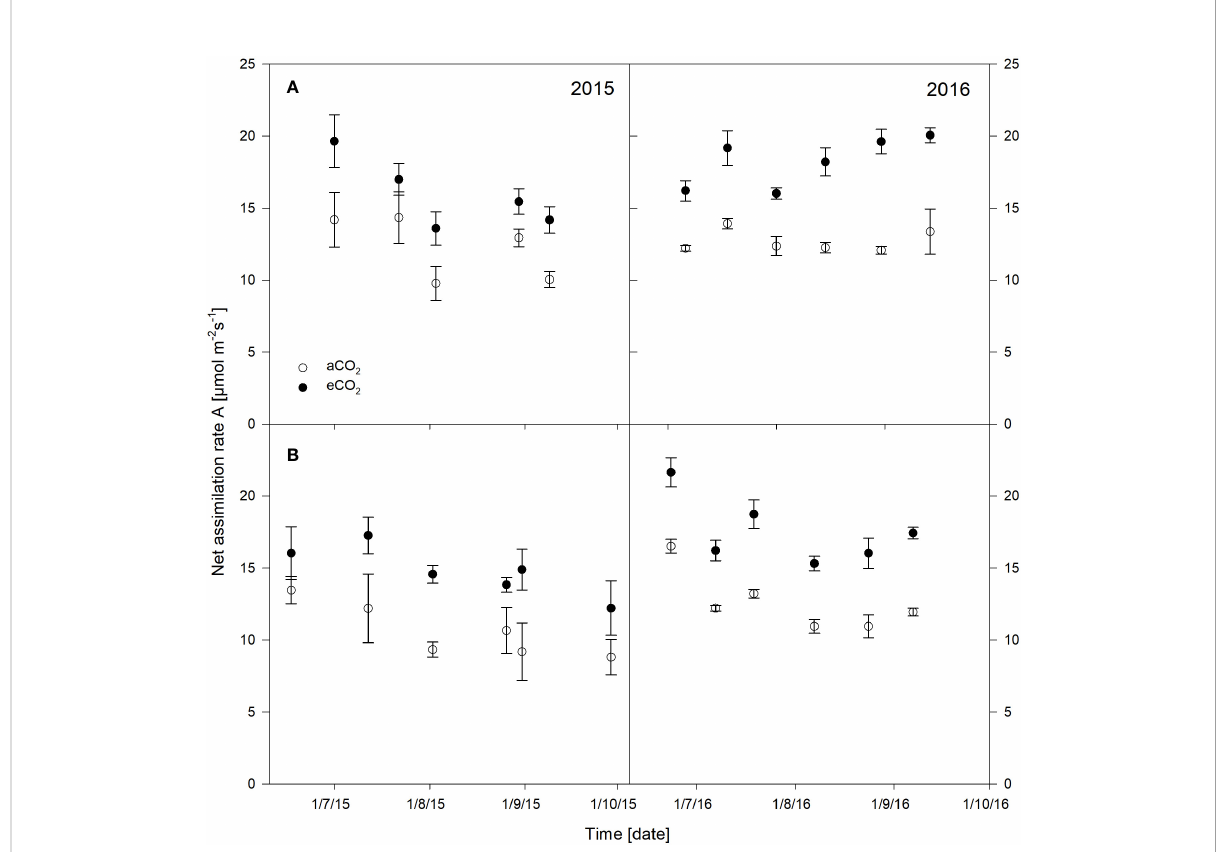
FIGURE 2 Net assimilation rate of Vitis vinifera cvs. Cabernet Sauvignon (A) and Riesling (B) measured over the seasons 2015 and 2016 under aCO 2 and eCO 2 conditions. Data represent mean ± SD of the three rings and nine leaves per